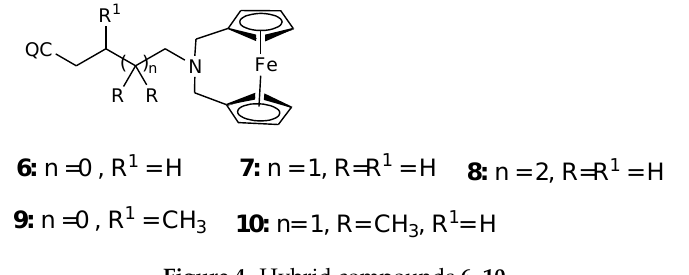
Figure 4. Hybrid compounds 6 – 10